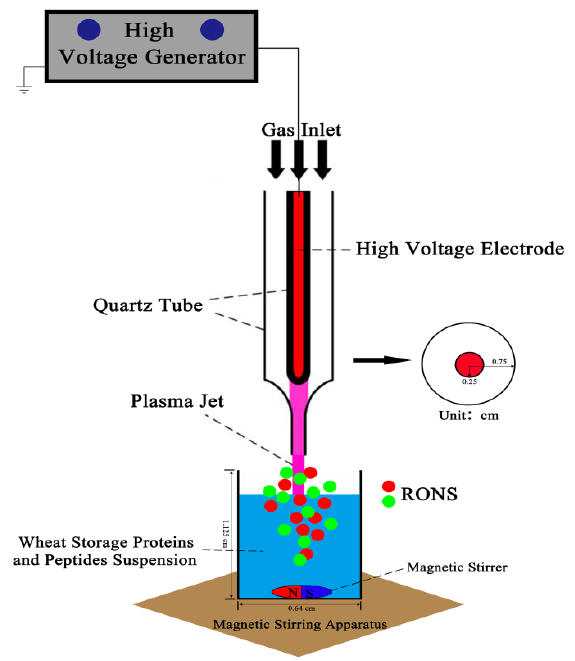
Figure 1. Schematic diagram of the plasma setup. The model peptides and gluten proteins in the 96-well plate were treated using a cold jet atmospheric pressure (CJAP) plasma jet.